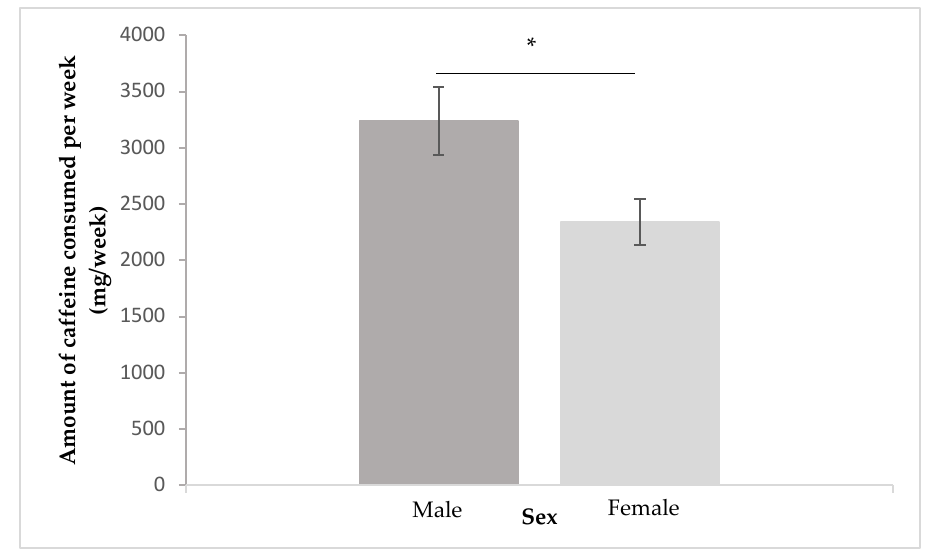
Figure 1. Caffeine intake per week (mg/week) by sex (* p < 0.05). Also, the data showed that caffeine consumption is significantly higher in partici- pants belonging to the age groups 26 – 29 and 30 – 35 ( M = 3001.5, SD = 2669.61; M = 3630.69, SD = 2873.89, respectively). The youngest age group was the one who reported a lower consumption ( M = 1651.64, SD = 1711.35).